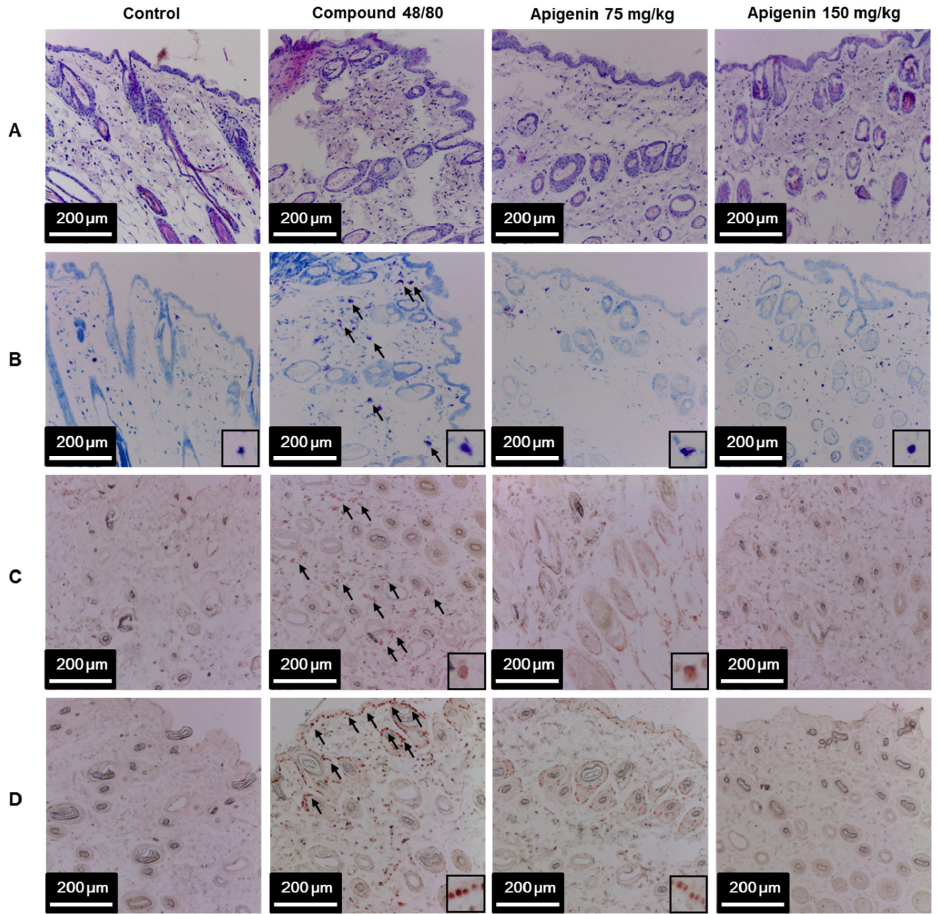
Figure 5. Effects of apigenin on compound 48/80-induced infiltration of mast cell and IL-31 expression in mice skin. Five mice each were placed into four groups: Compound 48/80 negative control; compound 48/80 positive control; compound 48/80 with apigenin 75 mg/kg treatment; and compound 48/80 with apigenin 150 mg/kg treatment. Compound 48/80 (50 μg/site, 0.1 mL each) was injected in the dorsal dermis of the mice neck 60 min after administration of 2% gelatin or apigenin at indicated concentrations. Skin tissue sections were stained with hematoxylin/eosin stains showing infiltration of polymorphonuclear leukocytes ( A ); toluidine blue showing mast cell infiltration into the skin ( B ); immunohistochemistry was done to demonstrate tryptase ( C ) and IL-31 ( D ) in the mice skin.